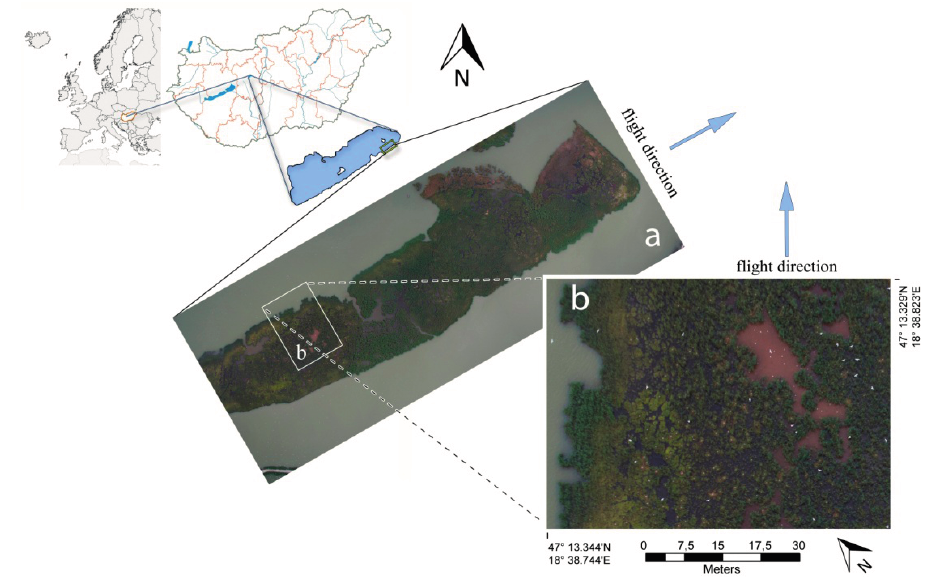
Figure 3. ( a ) Aerial ortho image mosaic of the first flight line of the black-headed gull colony sample area; ( b ) Enlarged detail of Figure